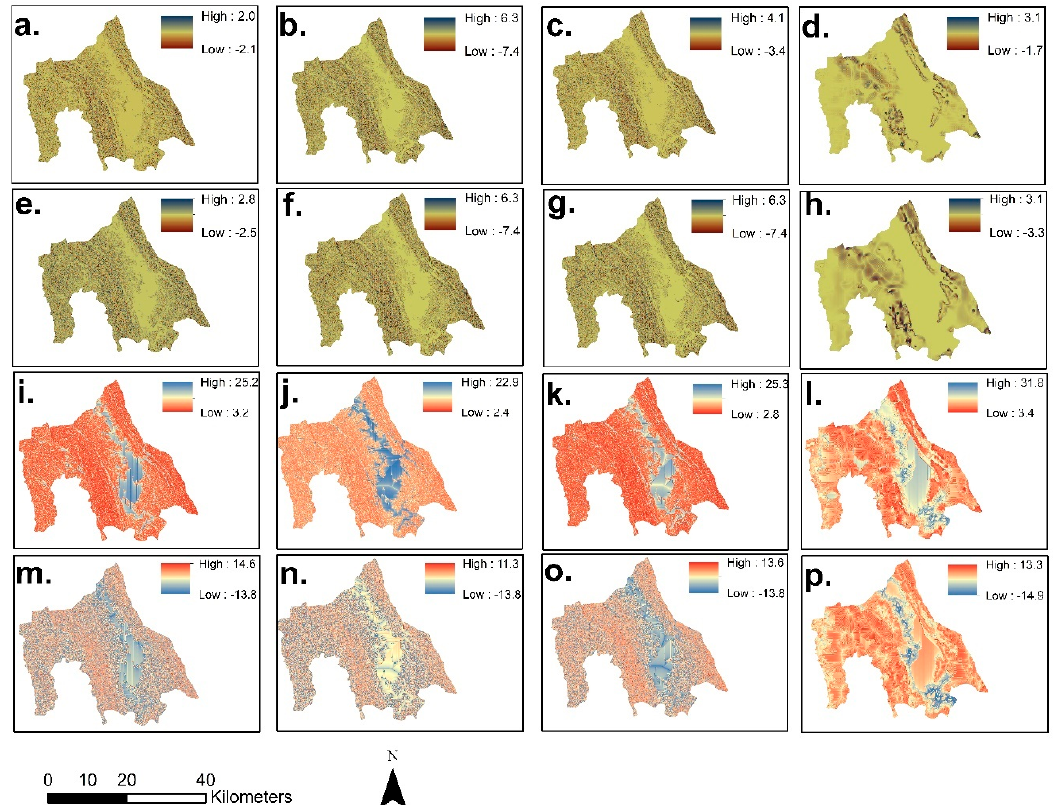
Figure A2. Landslide Causal Factors: ( a ) Plan Curvature (ASTER); ( b ) Plan Curvature (SRTM); ( c ) Plan Curvature (ALOS PALSAR); ( d ) Plane Curvature (SOB); ( e ) Profile Curvature (ASTER); ( f ) Profile Curvature (SRTM); ( g ) Profile Curvature (ALOS PALSAR); ( h ) Profile Curvature (SOB); ( i ) TWI (ASTER); ( j ) TWI (SRTM); ( k ) TWI (ALOS PALSAR); ( l ) TWI (SOB); ( m ) SPI (ASTER); ( n ) SPI (SRTM); ( o ) SPI (ALOS PALSAR); ( p ) SPI (SOB).